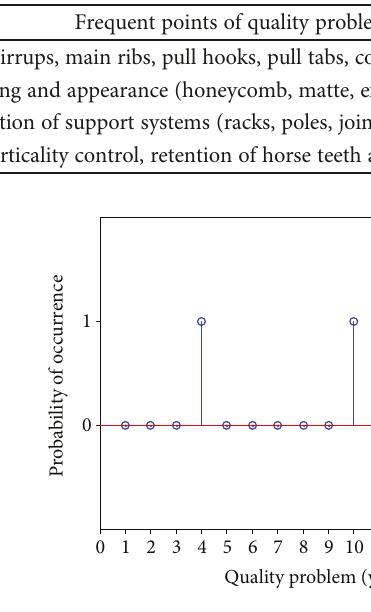
Figure 14: Prediction of engineering quality problems. Figure 15: Prediction of quality problems after